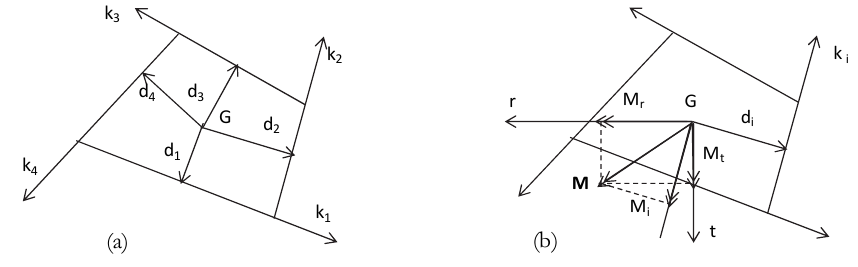
Figure 7: The quadrilateral interface. (a) Geometric aspect; (b) Mechanical aspect.